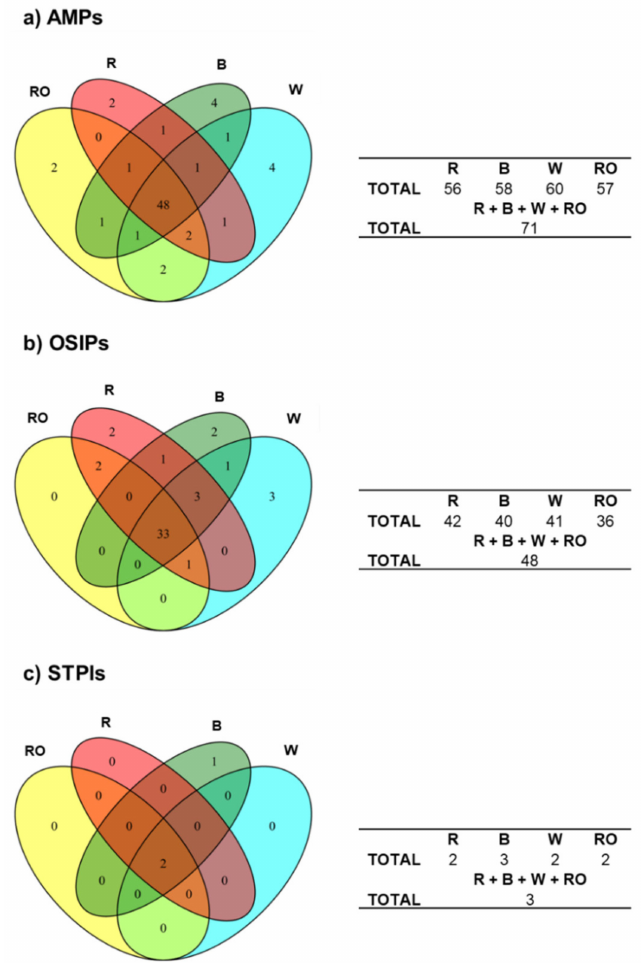
Figure 2. Venn diagrams of the identified ( a ) AMPs, ( b ) OSIPs, and ( c ) STPIs in the four analyzed commercial quinoa grains, R, B, W, and